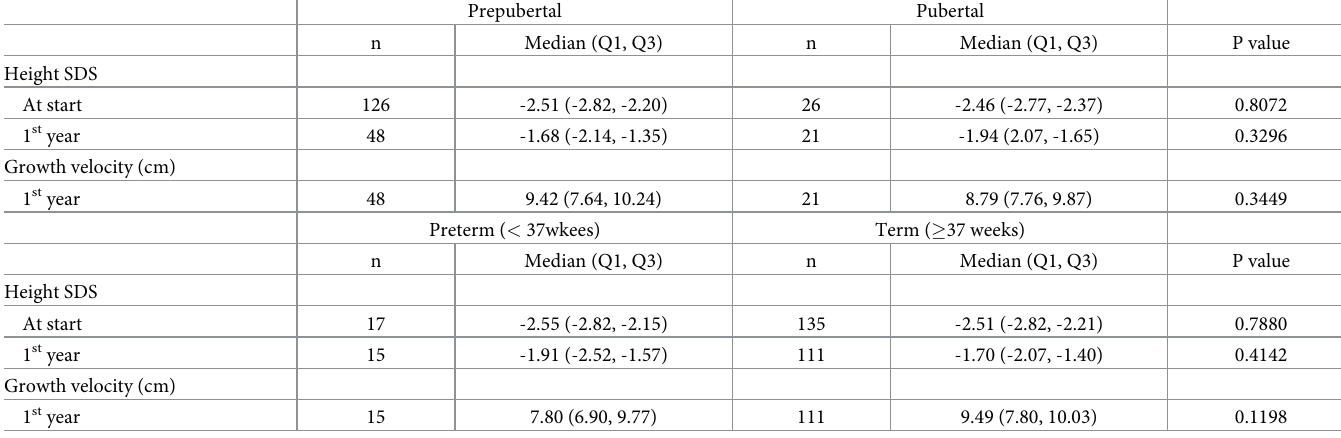
Table 2. Change in height SDS and growth velocity before and after treatment with GH according to pubertal status and gestational week in children with SGA (n = 152). Prepubertal